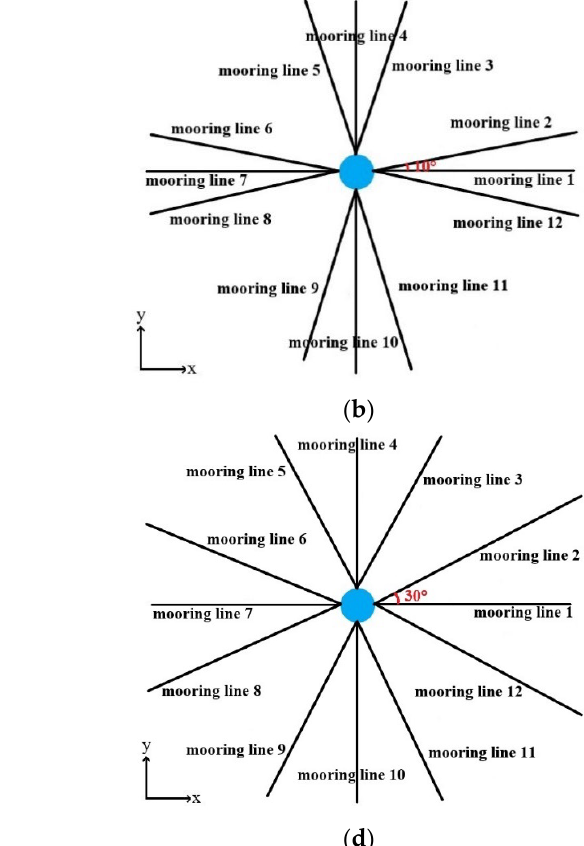
Figure 21. Influence of the angle between mooring lines on the mooring system. ( a ) The coupled system for analysis; ( b ) schematic diagram of the design of 10° between mooring lines; ( c ) schematic diagram of the design of 20° between mooring lines; ( d ) schematic diagram of the design of 30° between mooring lines.